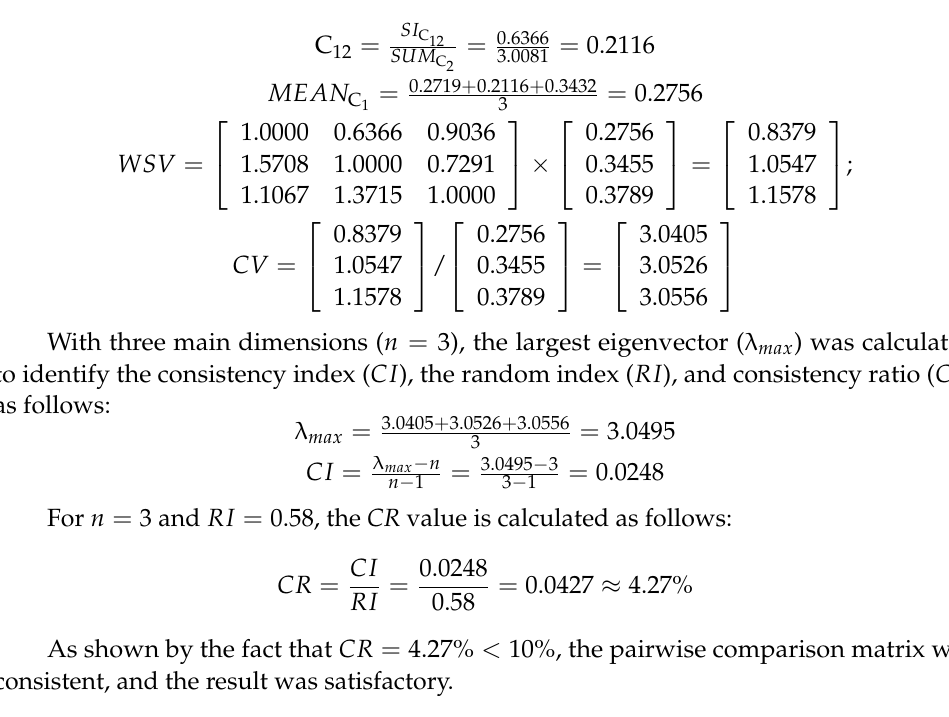
Table 6. The pairwise comparison matrix of SF-AHP. Left Criterion Is Greater Right Criterion Is Greater Dimension AMI